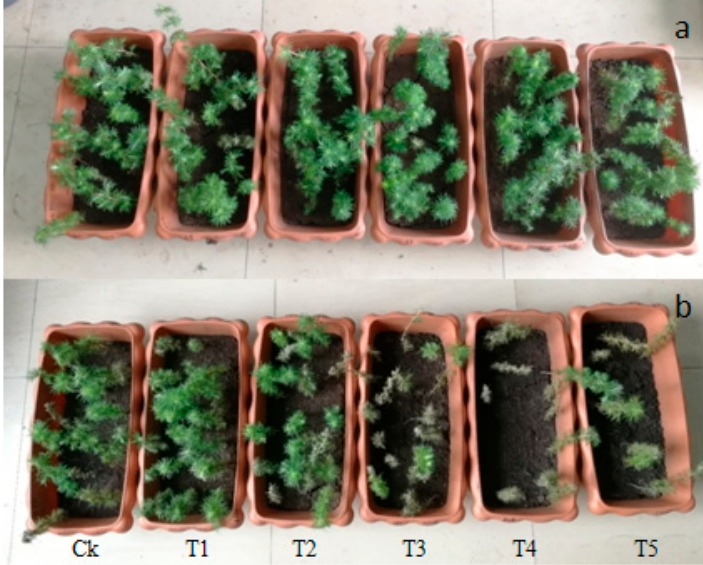
Figure 1. Growth vigor of L. olgensis seedlings at different concentrations of graphene for 30 ( a ) and 50 ( b ) days (from left to right, treated with 0 (Ck), 25, 50, 100, 250, and 500 mg L -1 , respectively; dead seedlings in ( b ) were removed).